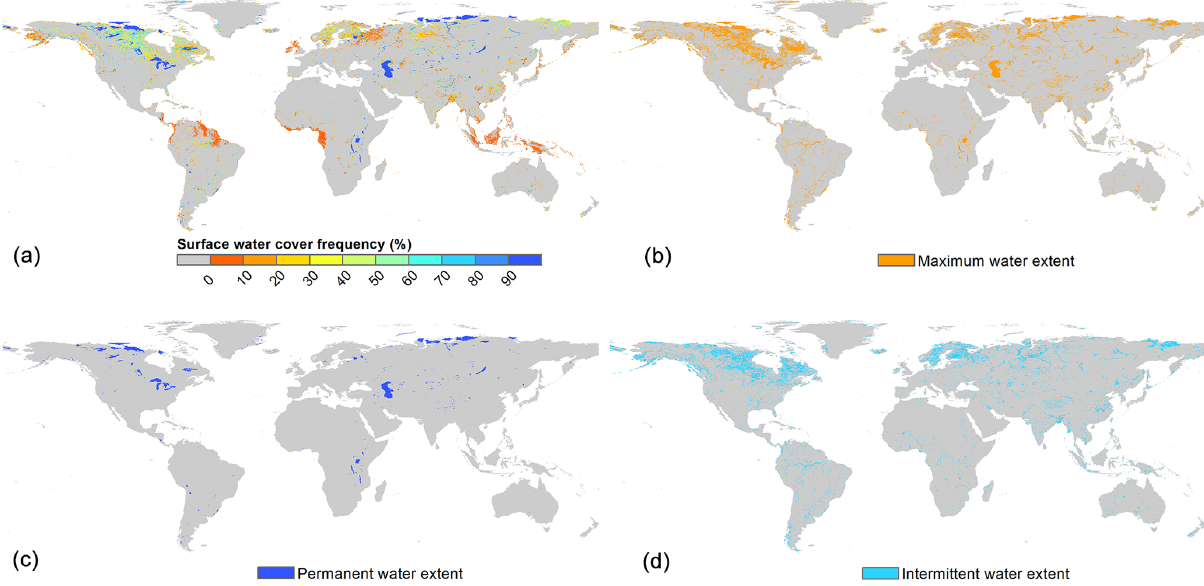
Figure 2. Global distribution of surface water cover frequency in 2020. (a) Global SWF map, (b) the maximum surface water extent, (c) the permanent surface water extent and (d) the intermittent surface water extent. The SWF was aggregated to 10 × 10km grids by averaging the valid SWF in each grid for